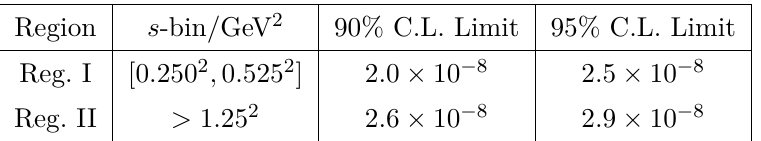
Table 2 . Current best-world limits on B ( D + → π + µ + µ − ) in two bins of the dilepton invariant mass s [38]. In the experimental search, the branching fraction excluding the resonant contributions is extrapolated assuming a phase space